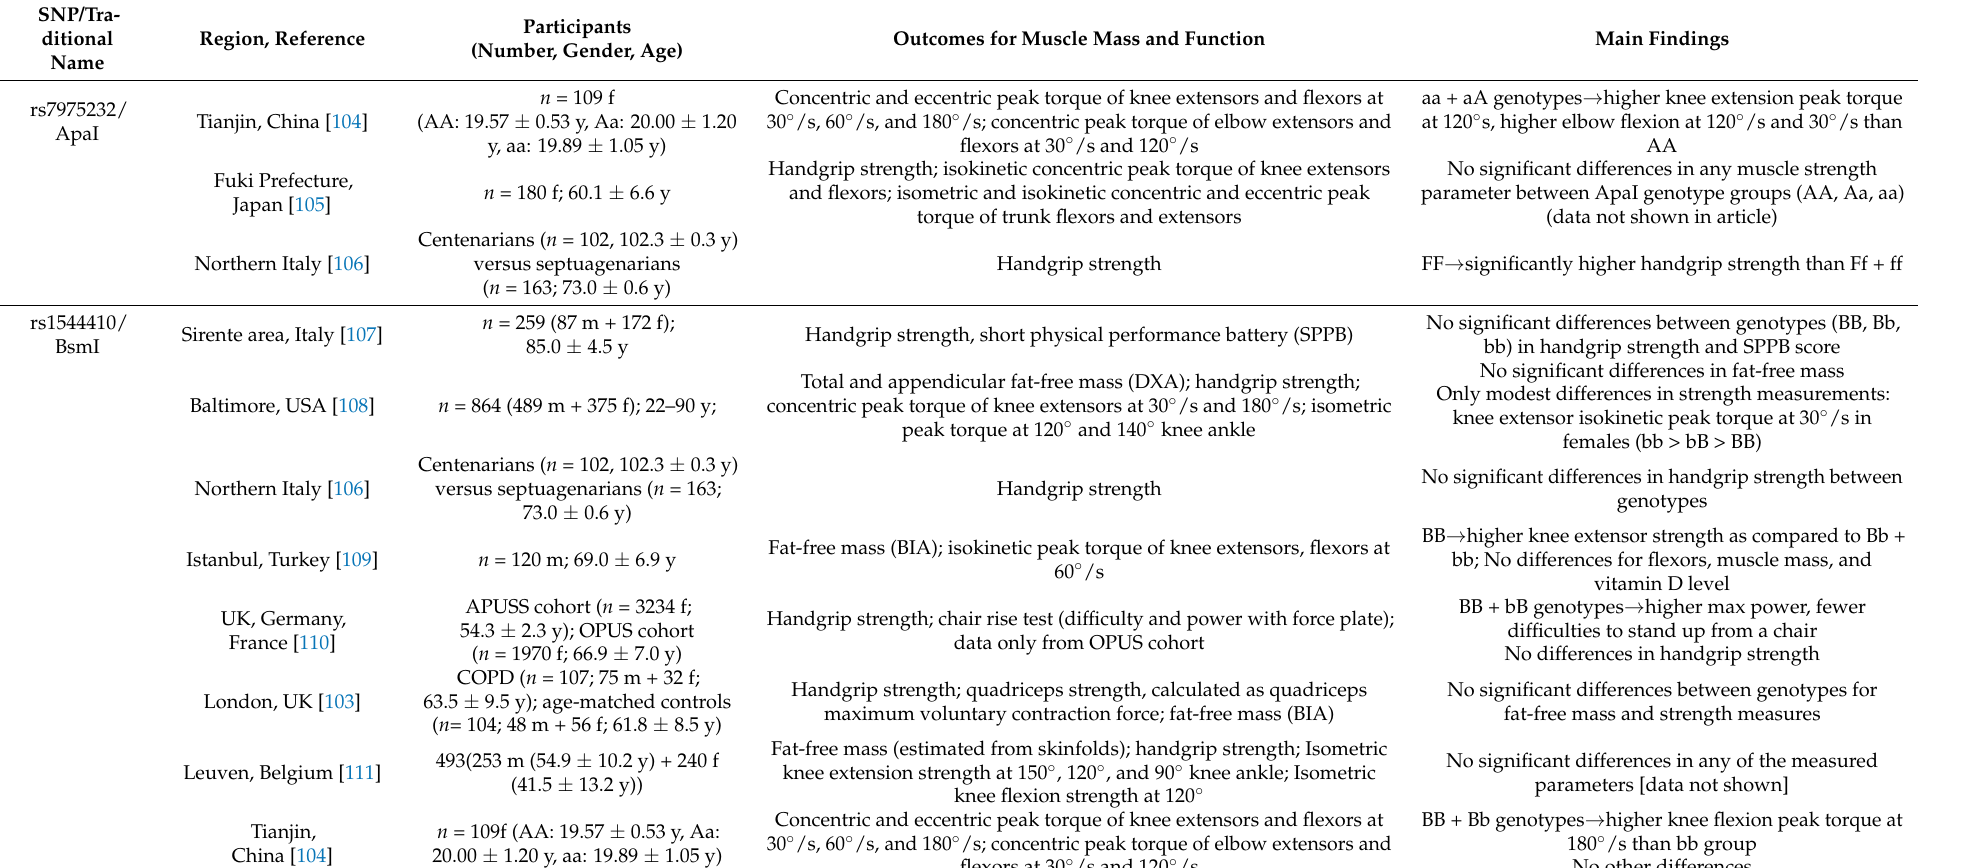
Table 2. SNPs in the VDR genes and their association with various muscle